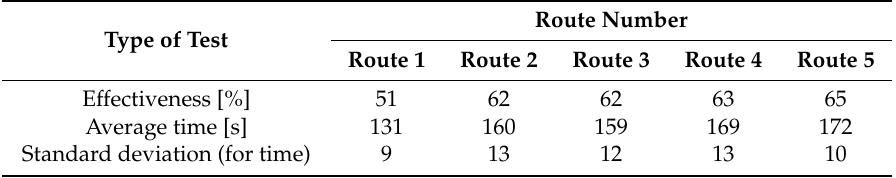
Table 2. Transition results of tested persons on 5 different routes in “no learning” mode.